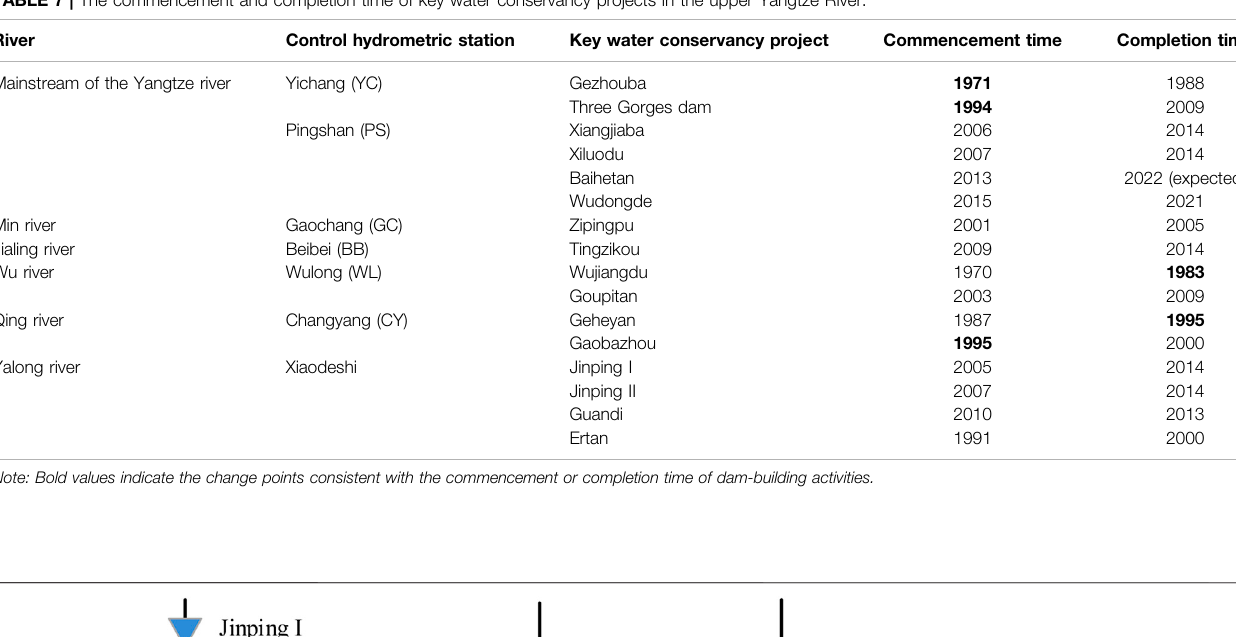
Note: Bold values indicate the change points con fi rmed by the causes of dam-building activities.